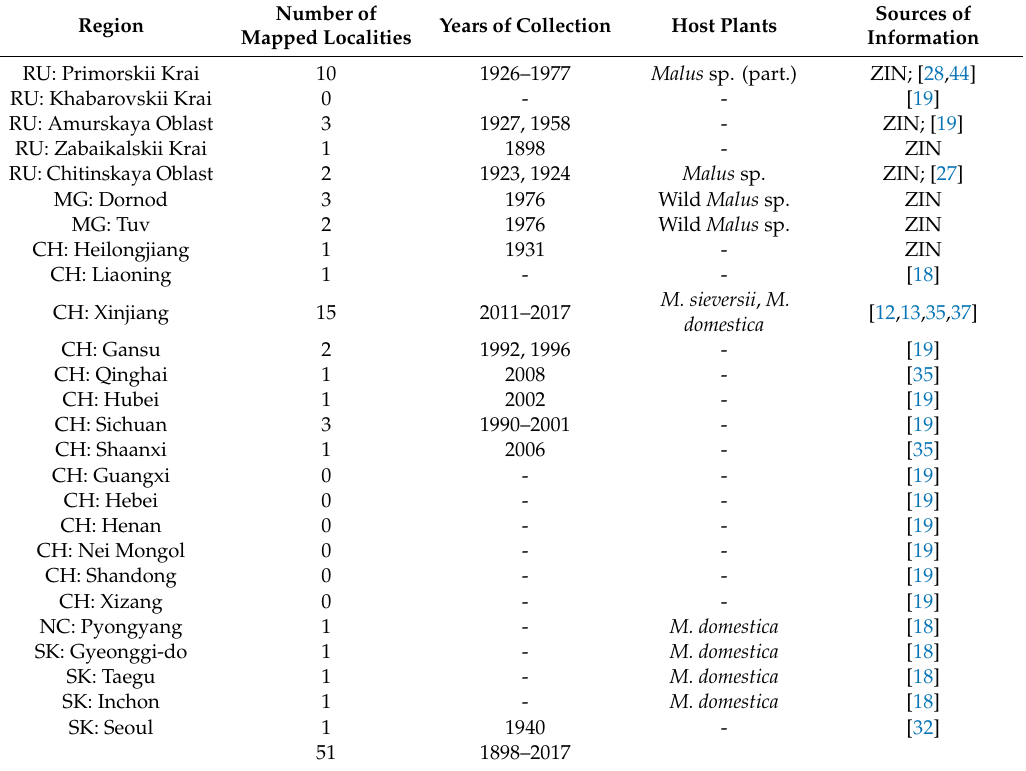
Table 1. Documented records of Agrilus mali Matsumura, 1924. CH—China, MG—Mongolia,